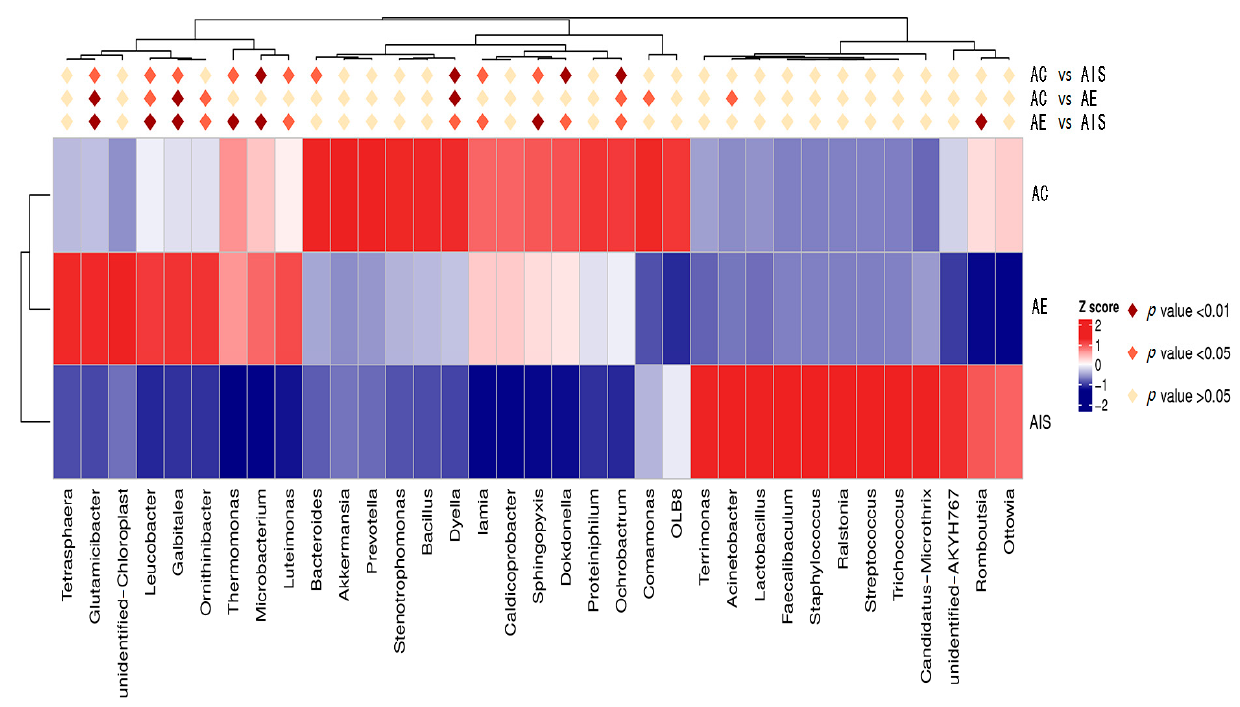
Figure 4. Heatmap of dominant bacterial genus and significant differences among initial sludge (AIS) and final products of control (AC) and vermicompost (AE).